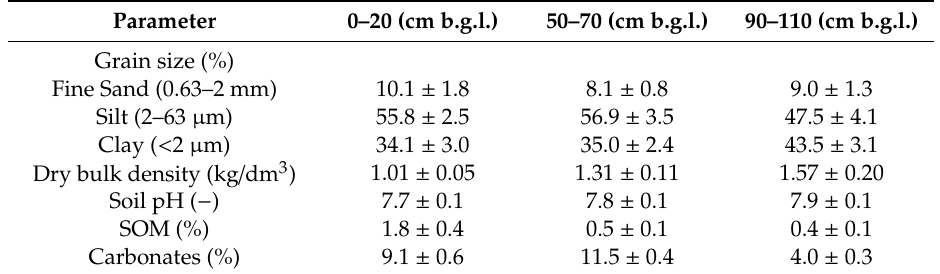
Table 2. Sediment parameters and their standard deviation from quintuplicate samples. Data sourced from Mastrocicco et al. [27].